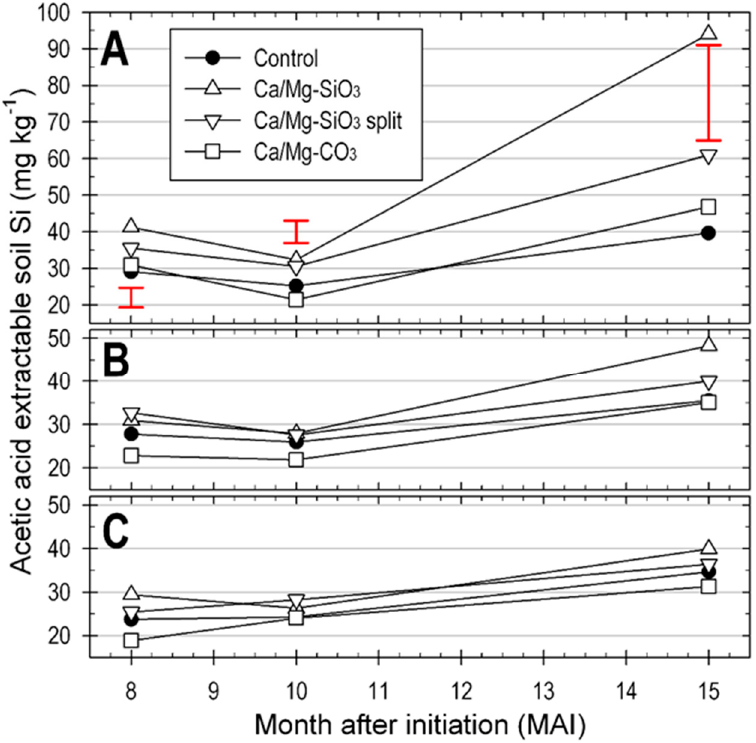
Figure 3. Acetic-acid (0.5 M) extractable soil Si within ( A ) 0 to 5 cm, ( B ) 5 to 10 cm, or ( C ) 10 to 15 cm creeping bentgrass rootzone depth by liming agent and month after initiation (MAI). For soil depth and MAI specified, error bars depict least significant difference (alpham = 0.05) between treatments.